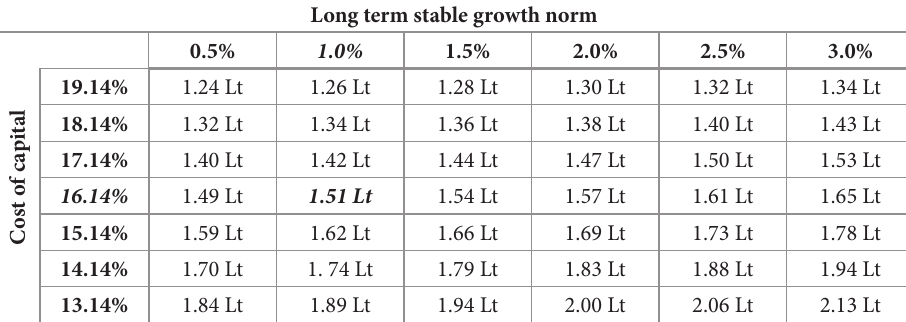
Table 10. Sensitivity analysis of the dividend valuation method Long term stable growth